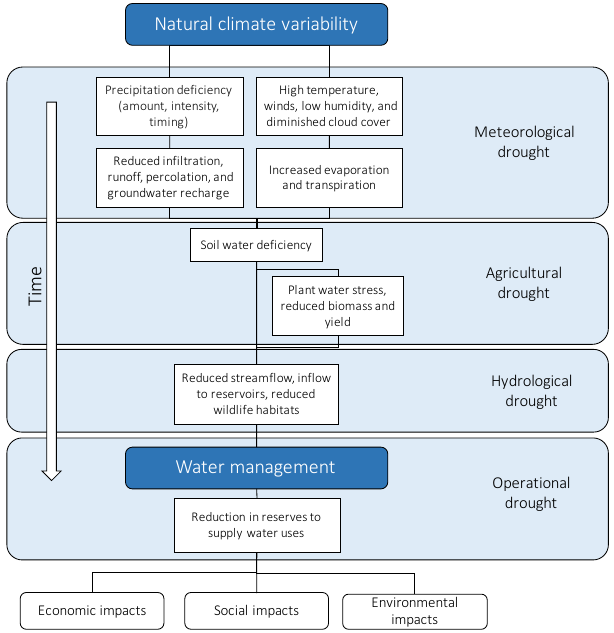
Figure 1. Development chain of droughts through time. Meteoro- logical drought, defined as a lack of precipitation over a region for a certain period of time, develops in the short term. Agricultural drought accounts for the plants and crops water stress; it develops in the medium term. Hydrological drought, defined as a period of low streamflow in watercourses as well as lake and groundwater lev- els below normal, develops in the long term. Operational drought, defined as a period with anomalous supply failures in a developed water exploitation system, develops in the long term. Figure adapted from Spinoni et al. (2016) to include operational